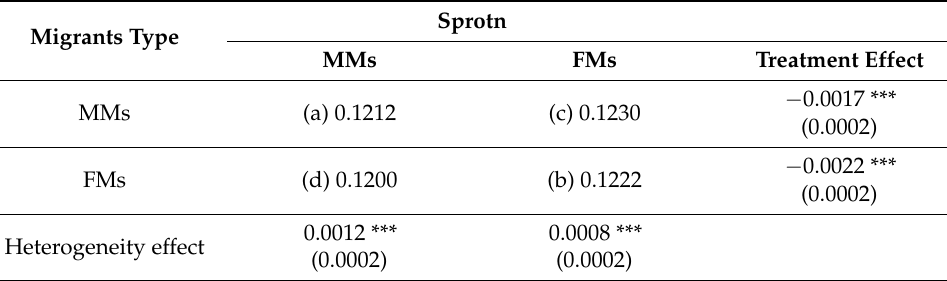
Table 6. Share of energy from protein, treatment, and heterogeneity effects of migrants.